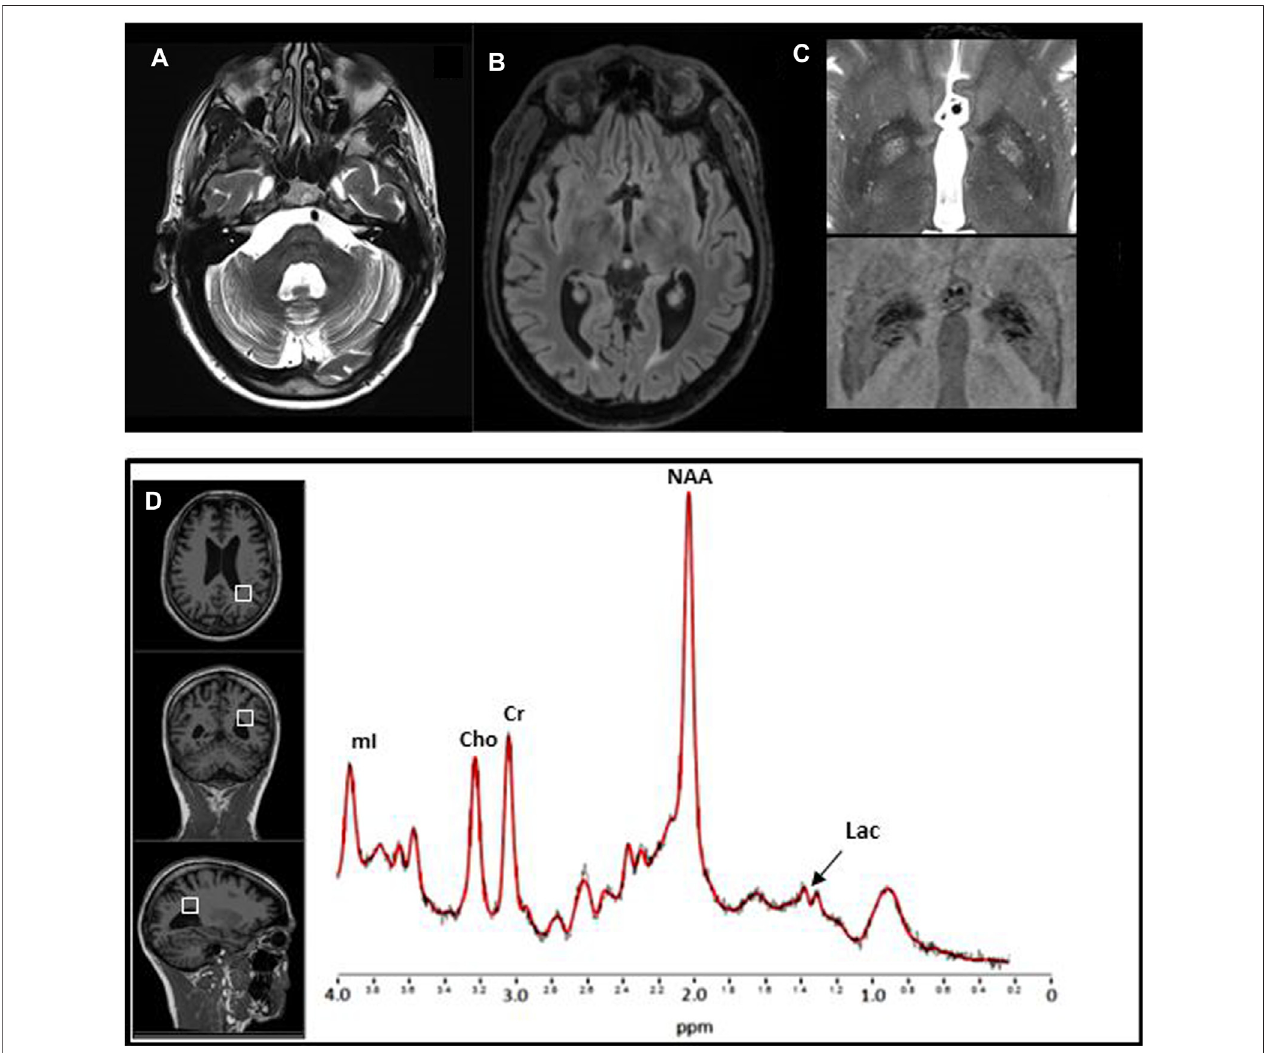
FIGURE 4 | Brain MRI and proton MR spectroscopy study. Brain MRI. Axial TSE T2 (A) and FLAIR T2 (B) weighted images show, respectively, IV ventricle dilation and lateral ventricle occipital horn dilation associated with periventricular hyperintensity. On axial TSE T2, bilateral symmetrical hyperintense signal changes in the globi pallidi[ (C) upperimage],withcorrespondenthypointensityontheaxialSWI[ (C) lowerimage],consistentwithmineralization,isevident. (D) 1HMRspectrum(3TSiemens Skyra scanner, TR/TE/NS = 2000 ms/30 ms/64) from the volume of interest (8 ml) in the left parietal white matter (on the left the localization on 3D T1 images) shows the resonance at 1.3 ppm coming from pathological traces of lactate (Lac). NAA = N-acetyl aspartate, Cho = choline, Cr = creatinine, mI =